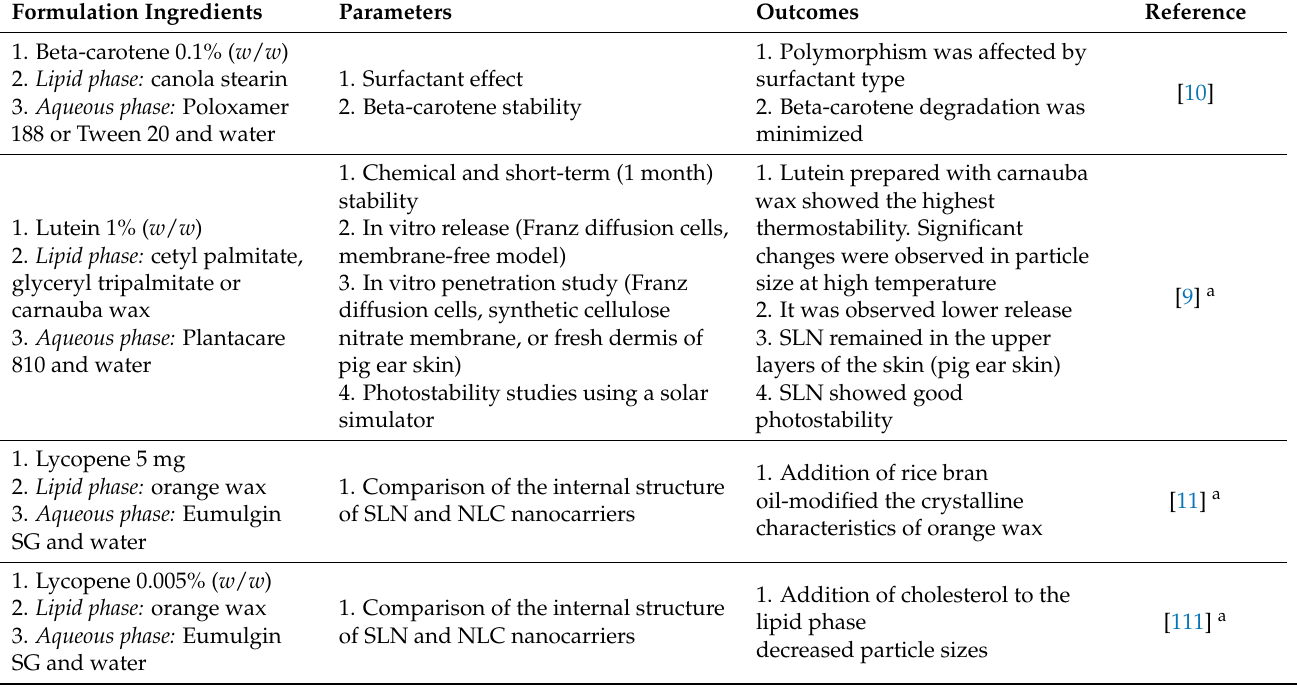
Table 1. Studies on carotenoid encapsulation in solid lipid nanoparticles (SLN) employing high-pressure homogenization as the preparation method. Formulation Ingredients